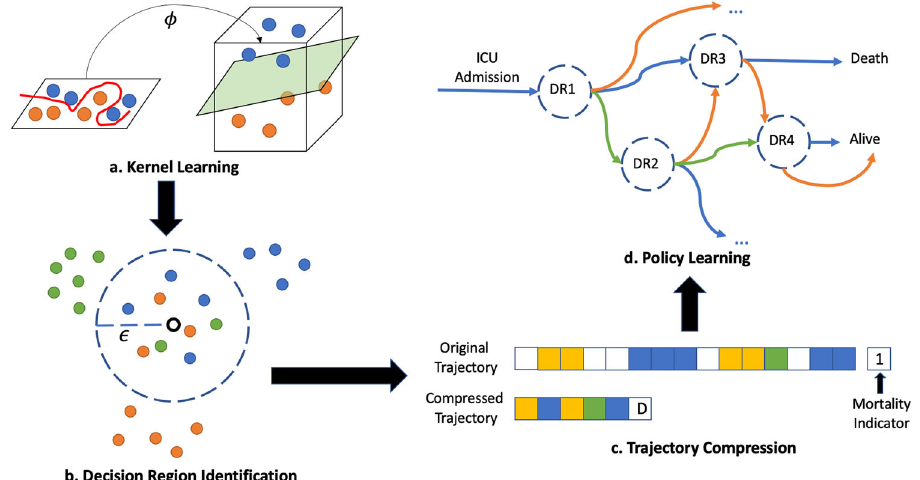
Fig. 1 The decision point pipeline. a We optimize a similarity metric to re fl ect physicians' perceptions of patient similarity. b We identify decision regions (DR), or areas where similar patients frequently receive different treatments. c We summarize patient trajectories in terms of decision regions. d We use this Markov Decision Process to learn an optimal treatment policy for each decision